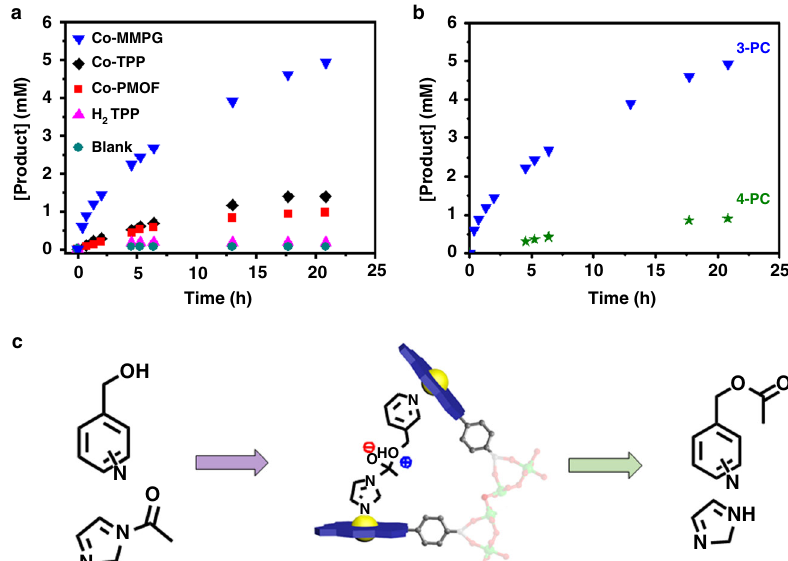
Fig. 4 Catalytic property tests. a Kinetic pro fi le of producing 3-acetoxymethylpyridines catalyzed by various catalysts; b kinetic pro fi le of acryl-transfer reactions between N-acetylimidazole (NAI) and 3-pyridylcarbinol (3-PC) or 4-pyridylcarbinol (4-PC) catalyzed by Co-MMPG; c a possible local structure of the pocket, in which convergent binding sites are positioned in such a way that substrate molecules can be held in close proximity. Source data are provided as a Source Data fi